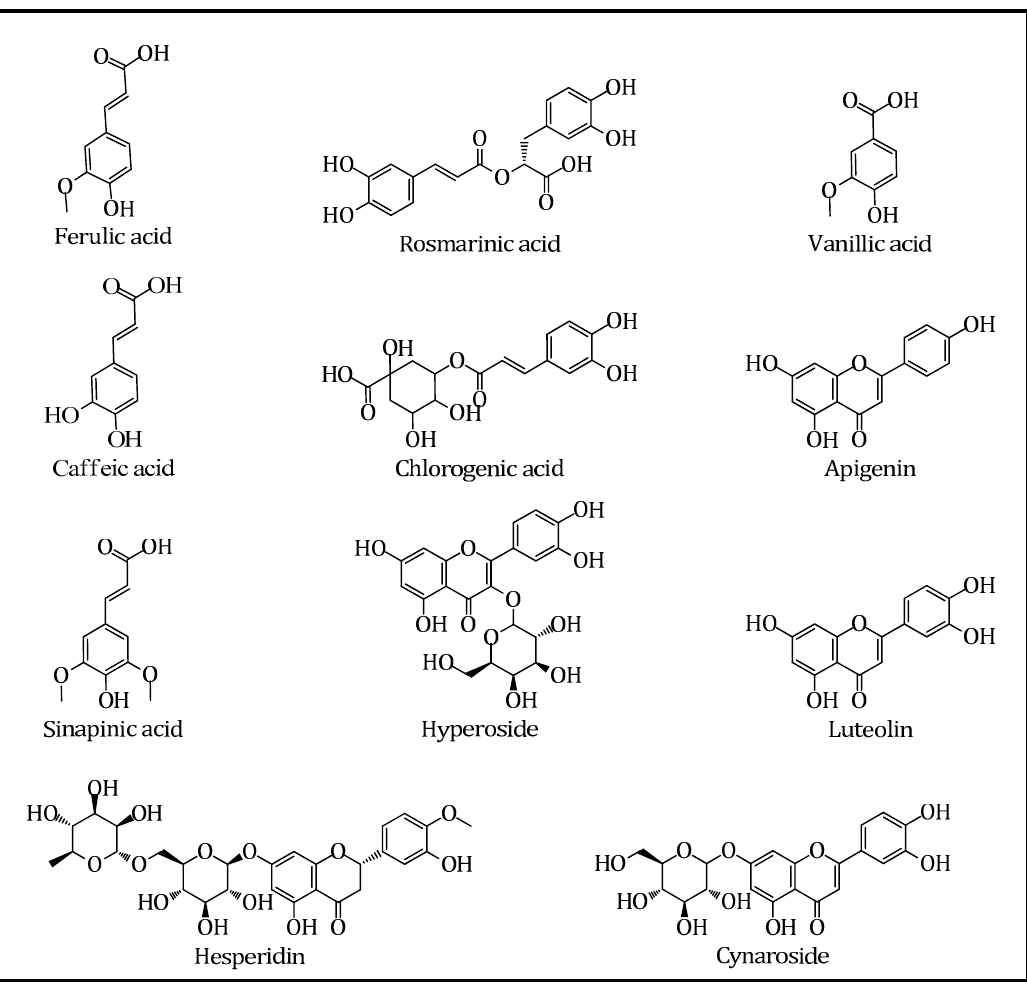
Figure 2. Major phenolic compounds identified in the solvent extracts from Z. taurica subsp. taurica .